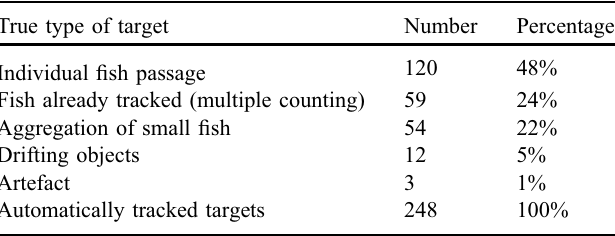
Table 1. Visual checking of targets automatically tracked by Sonar5- Pro by use of SMC software.